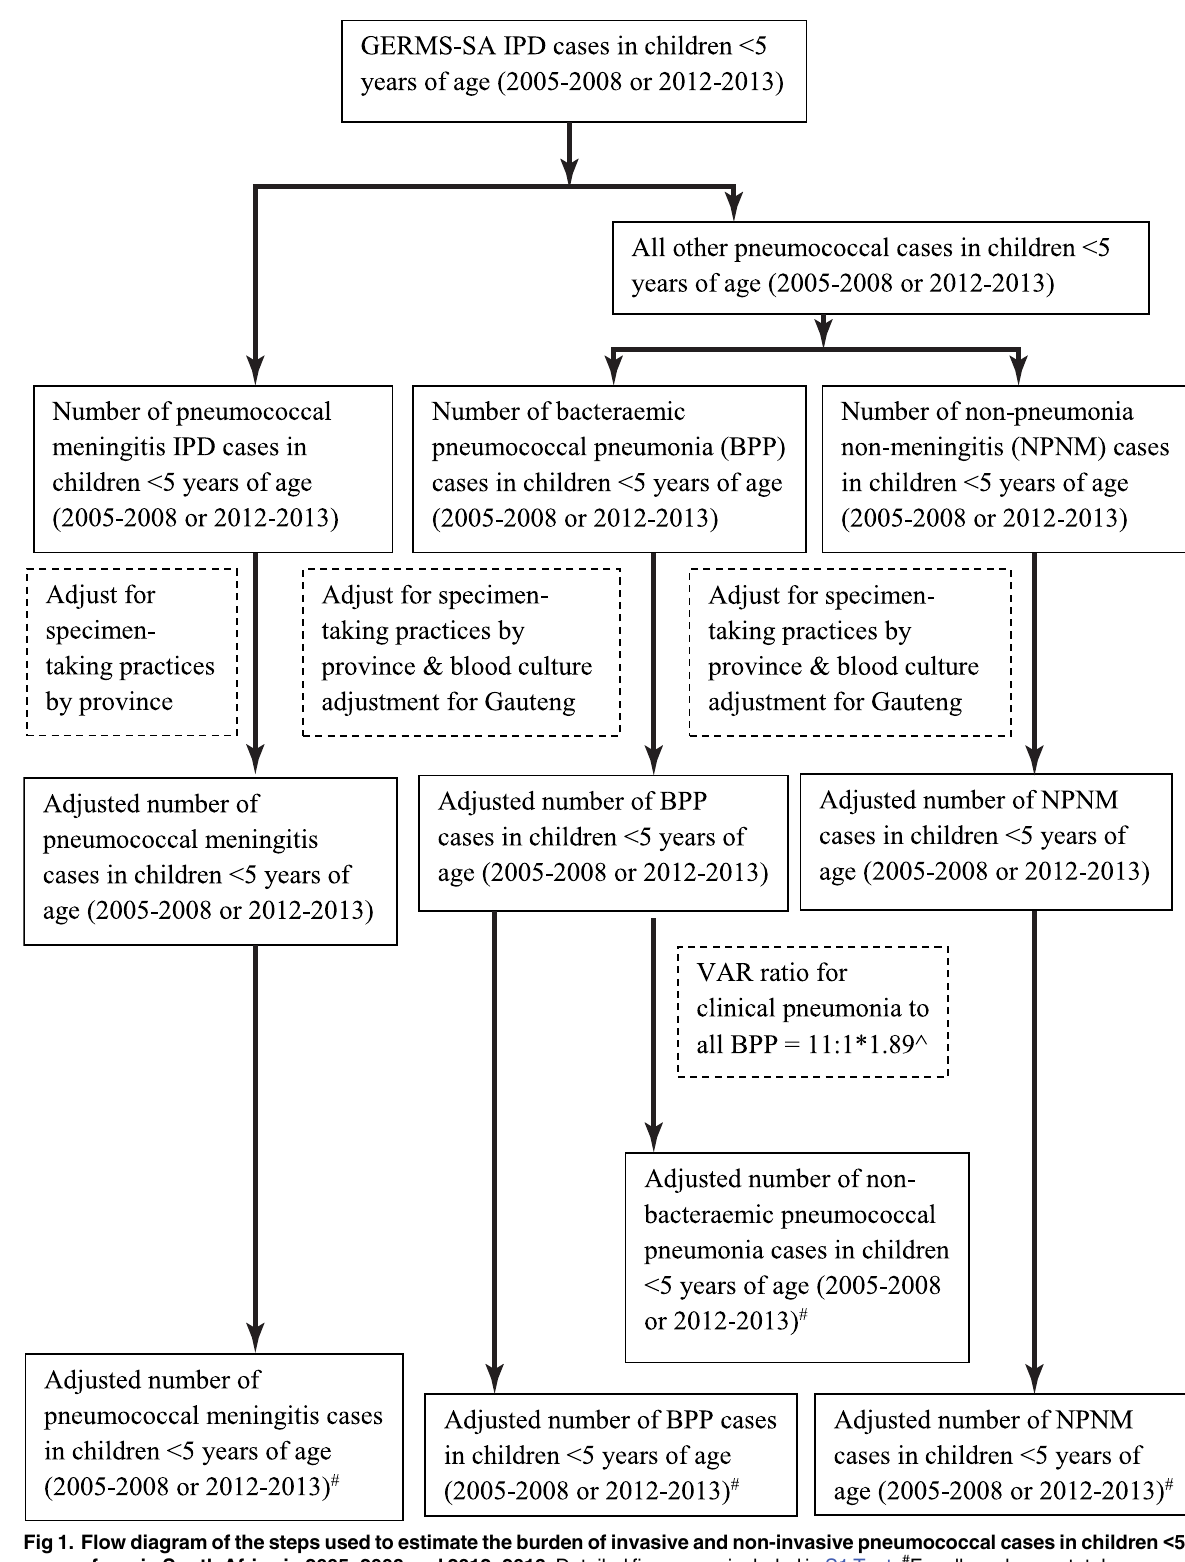
Fig 1. Flow diagram of the steps used to estimatethe burden of invasive and non-invasive pneumococcal cases in children < 5 years of age in South Africa in 2005–2008and 2012–2013. Detailedfigures are includedin S1 Text. # For all syndromes total case numbers as well as numbers stratified by HIV status were determined. ^Additional adjustment(1.89) for difference in VE estimated with use of urinary antigen.